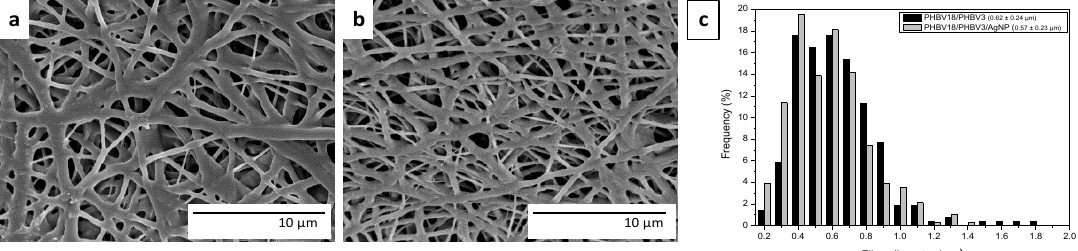
Figure 1. Scanning electron microscopy (SEM) images of the electrospun fibers: ( a ) PHBVs (PHBVs corresponds to a mixture between PHBV3 and PHBV18 (without silver nanoparticles), PHBV3, poly(3-hydroxybutyrate-co-3 mol %-3-hydroxyvalerate), PHBV18, poly(3-hydroxybutyrate-co-18 mol %-3-hydroxyvalerate)); ( b ) PHBVs/ silver nanoparticles (AgNPs); ( c ) size distribution of fibers.